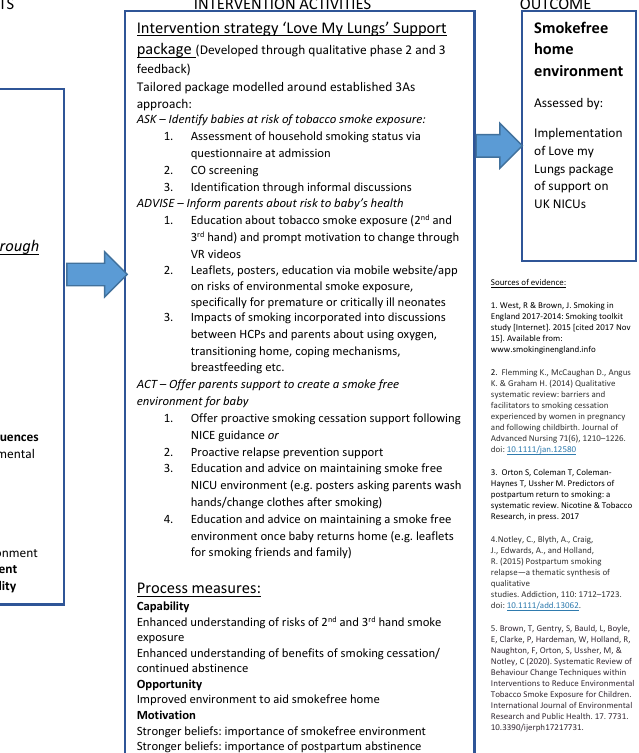
Figure 1. Intervention logic